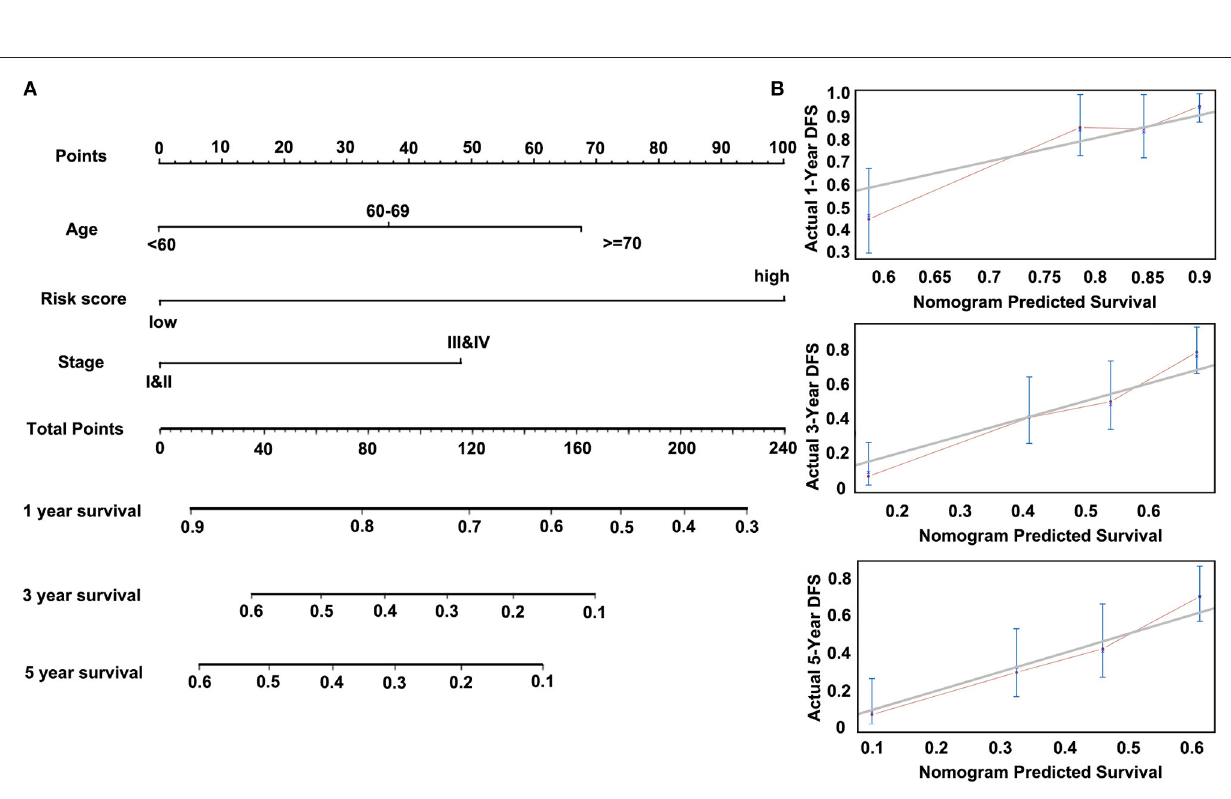
Frontiers in Oncology |